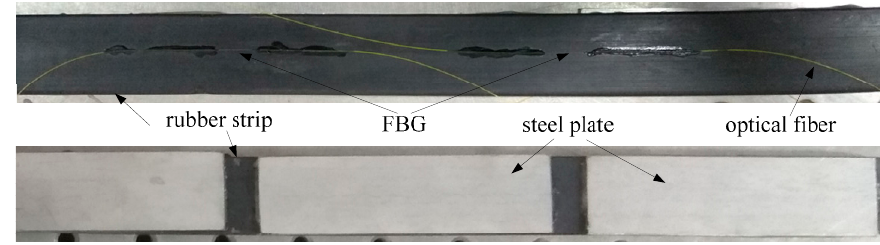
Figure 1. Exploded view of the FBG strain sensor. ( a ) the front view, ( b ) the side view.